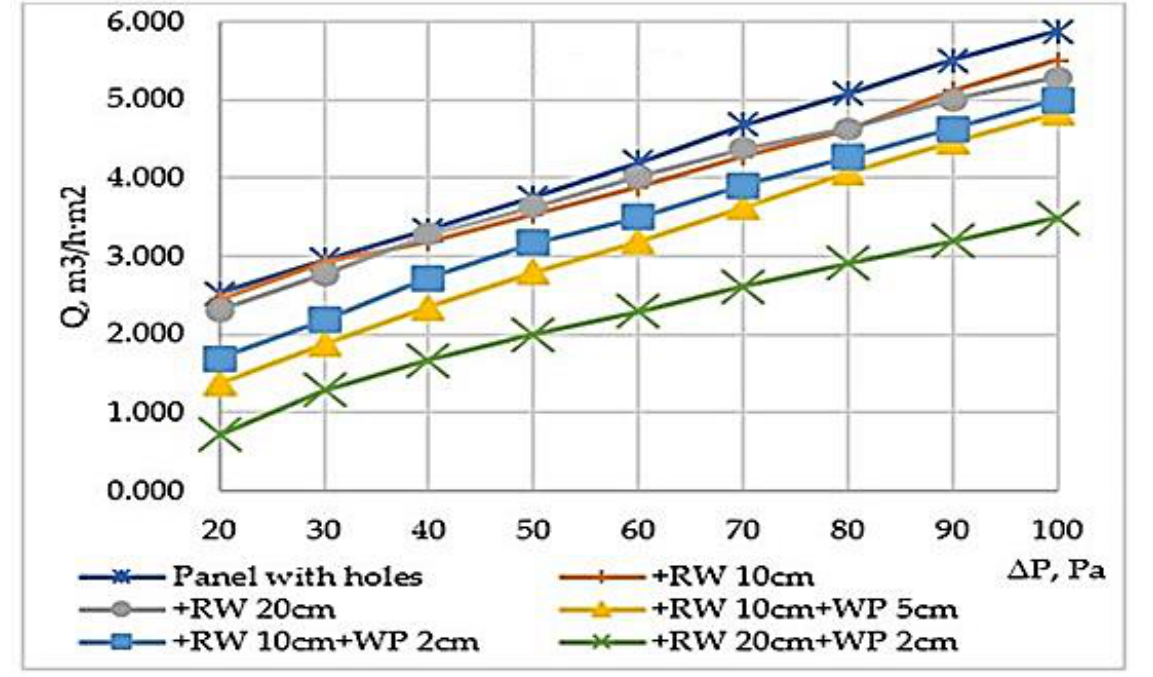
Figure 3. The dependence of air permeability on the pressure difference when using different variants of insulation used in construction. Source: own study based on [28].